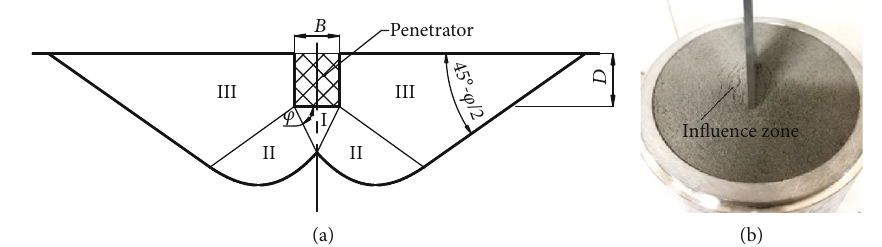
Figure 1: In fl uence zone: Prandtl theory (a) and the experiment (b).